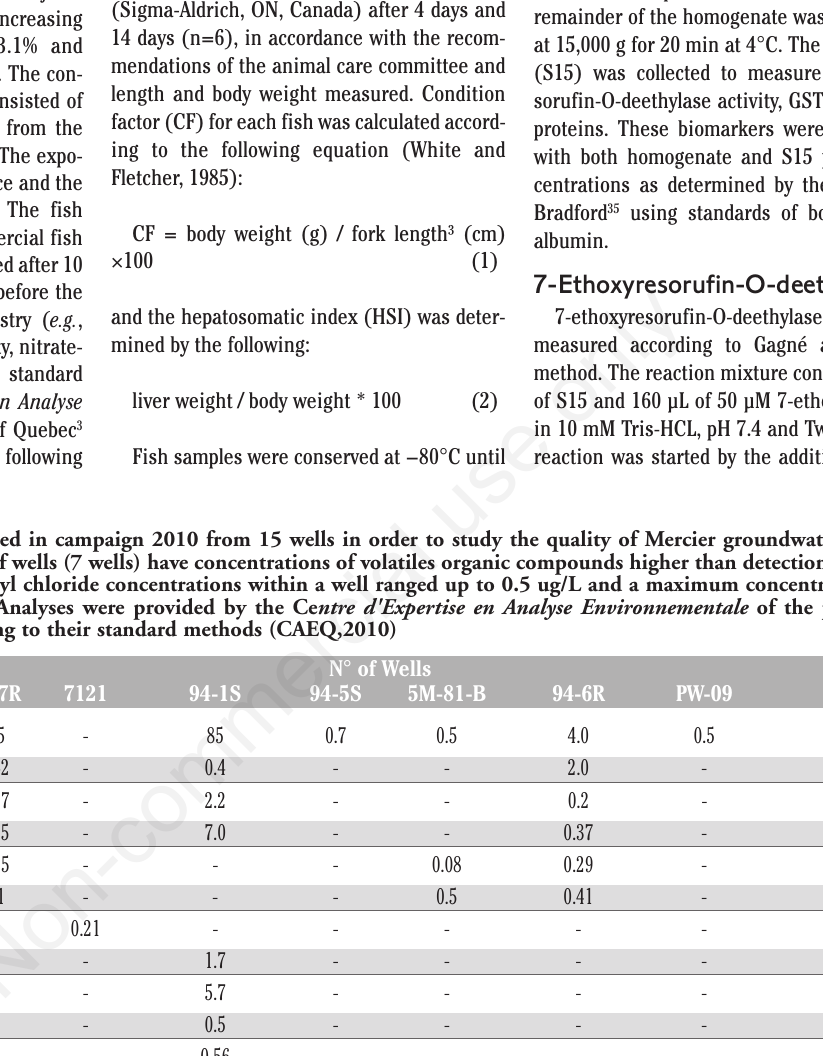
1,1-Dichloroethane